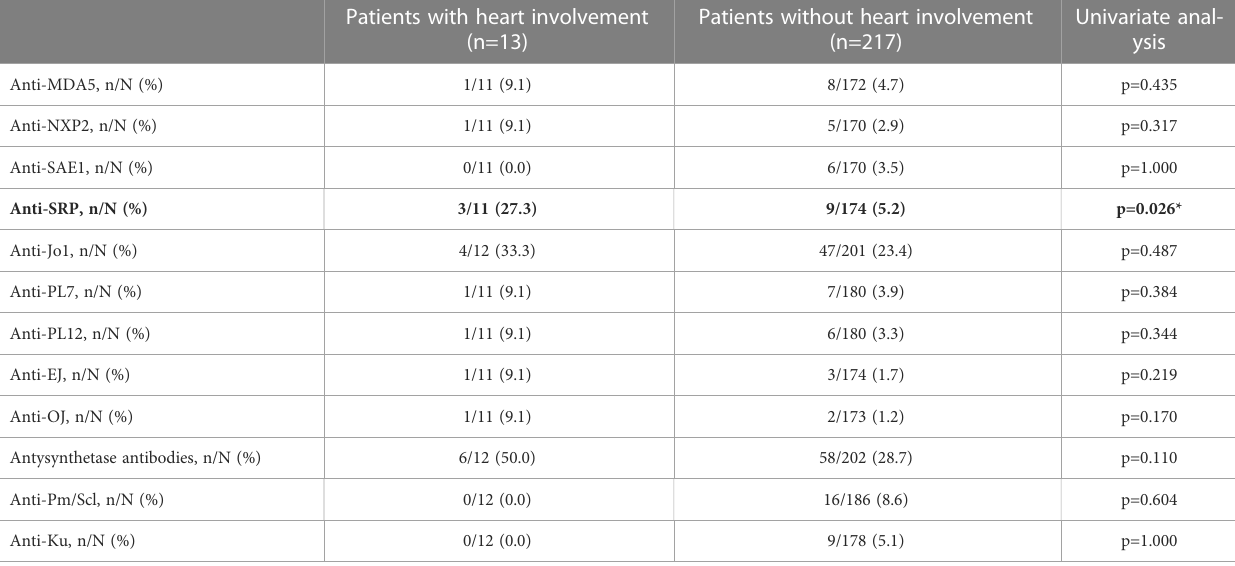
AccordingtoBonferroni ’ scorrectionformultipletesting,variableswereconsideredaslikelyassociations(*)orde fi niteassociations(**).n,numberofpatientspositiveforthevariableofinterest; N, number of patients without missing information regarding the variable of interest; MMT8, manual muscle testing; DAS, disease activity score; STIR, short tau inversion recovery; MRI, magnetic resonance imaging; ANA, anti-nuclear antibodies; SSA/SSB, anti,Sjögren ’ s syndrome-related antigen A/B; RNP, ribonucleoprotein; TIF1 g , transcription intermediary factor 1-gamma; MDA5, melanoma differentiation-associated gene 5; NXP2, nuclear matrix protein 2; SAE, small ubiquitin-like modi fi er activating enzyme; SRP, signal recognition particle; Jo1, histidyl tRNA synthetase; PL7, threonyl tRNA synthetase; PL12, anti-alanyl tRNA synthetase; EJ, glycyl tRNA synthetase; OJ, isoleucyl tRNA synthetase; Pm/Scl, polymyositis/scleroderma. All statistically signi fi cant differences between groups are shown in